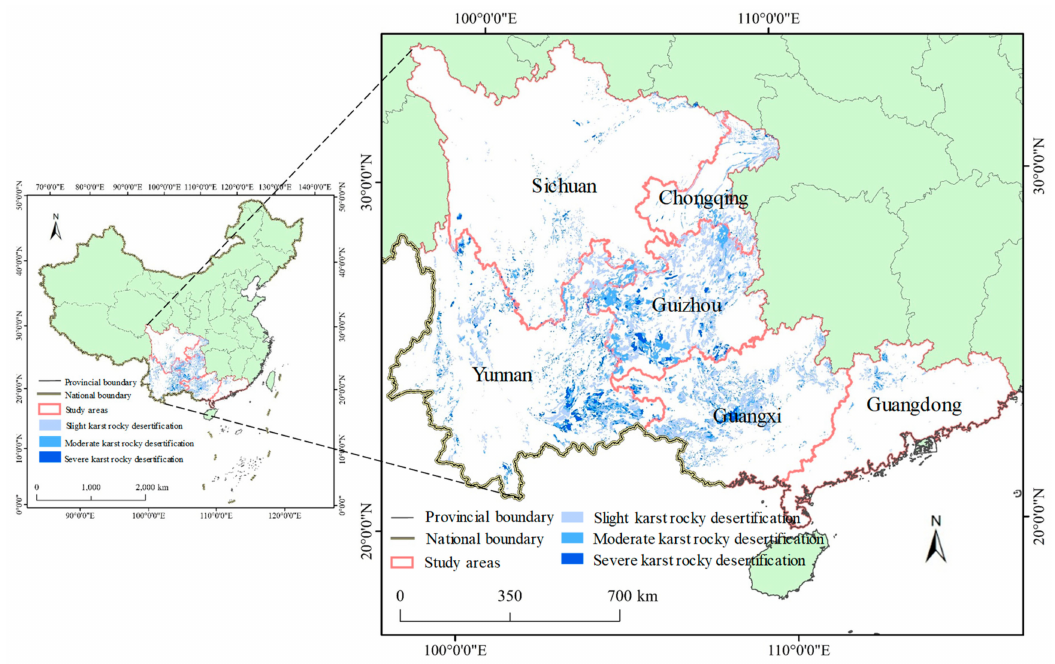
Figure 1. The spatial distribution of karst rocky desertification areas in southern